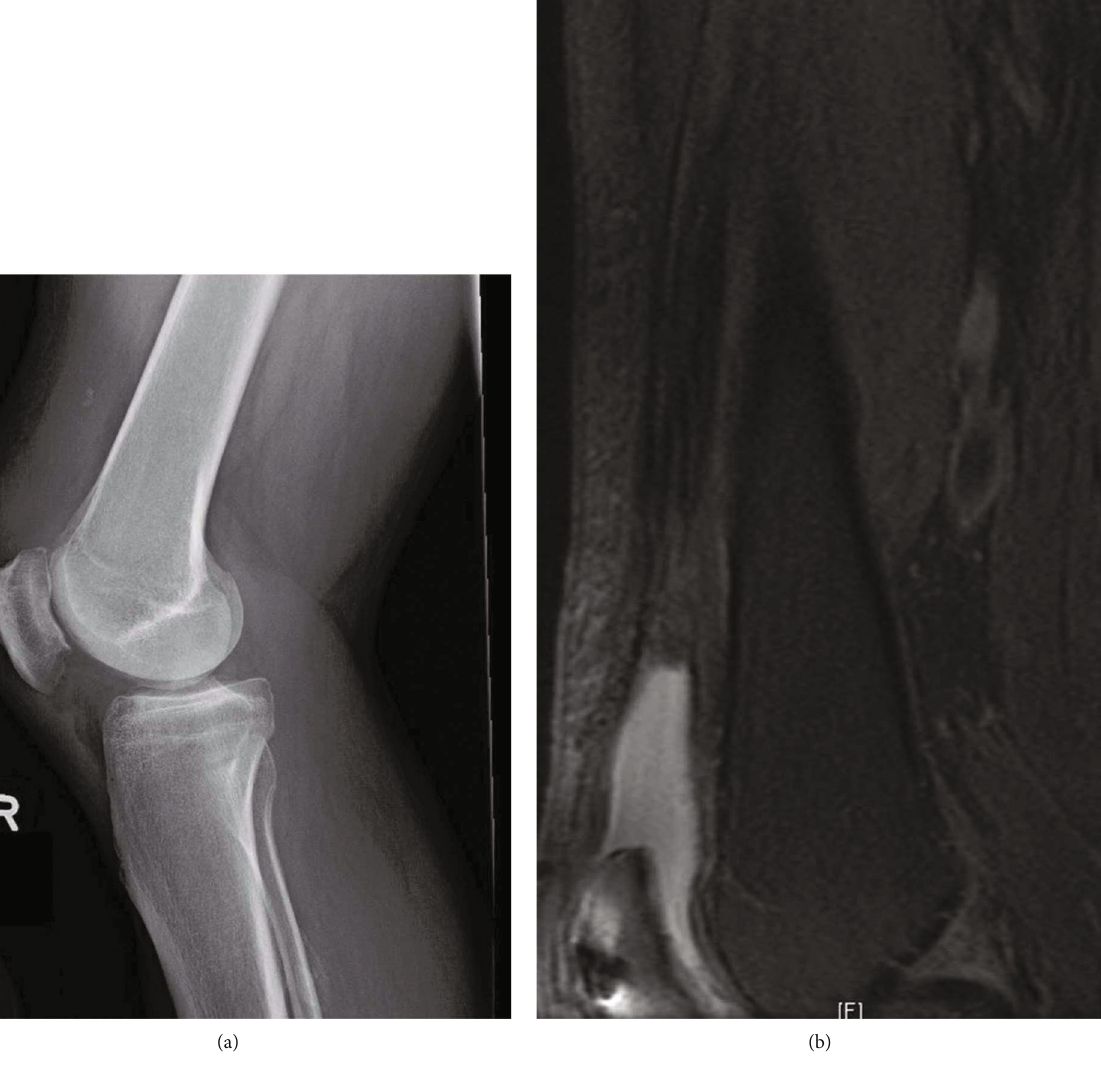
Figure 1: Patient 1 (a) lateral X-ray showing no signi fi cant bony injury and (b) sagittal MRI images of the distal femur showing signi fi cant QT disruption, tendon retraction, and postsurgical patellar